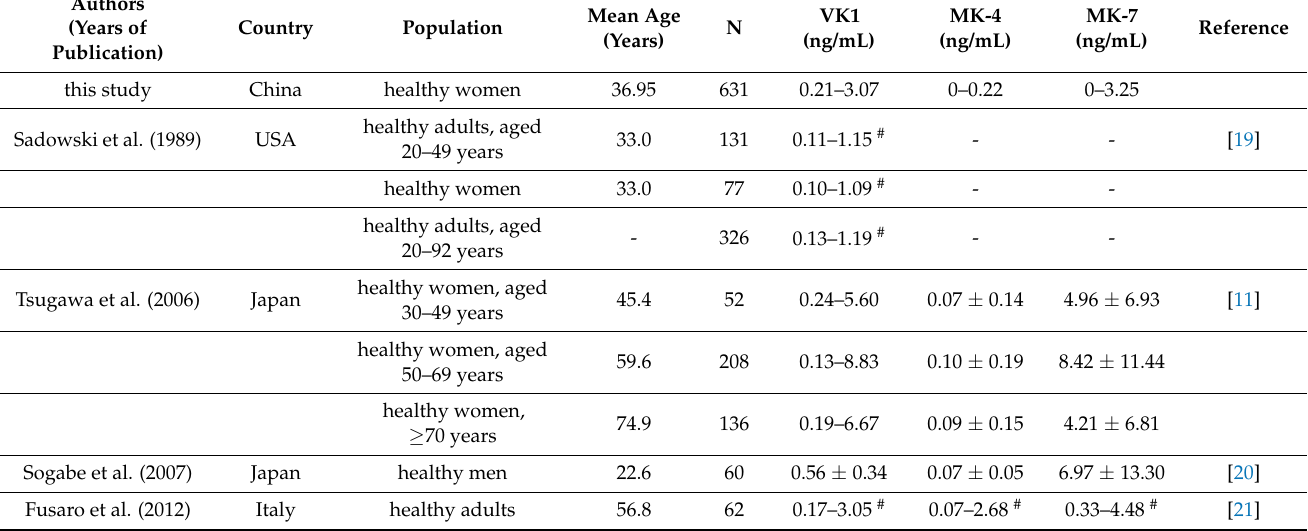
Table 6. Reference range or concentration for vitamin K reported in